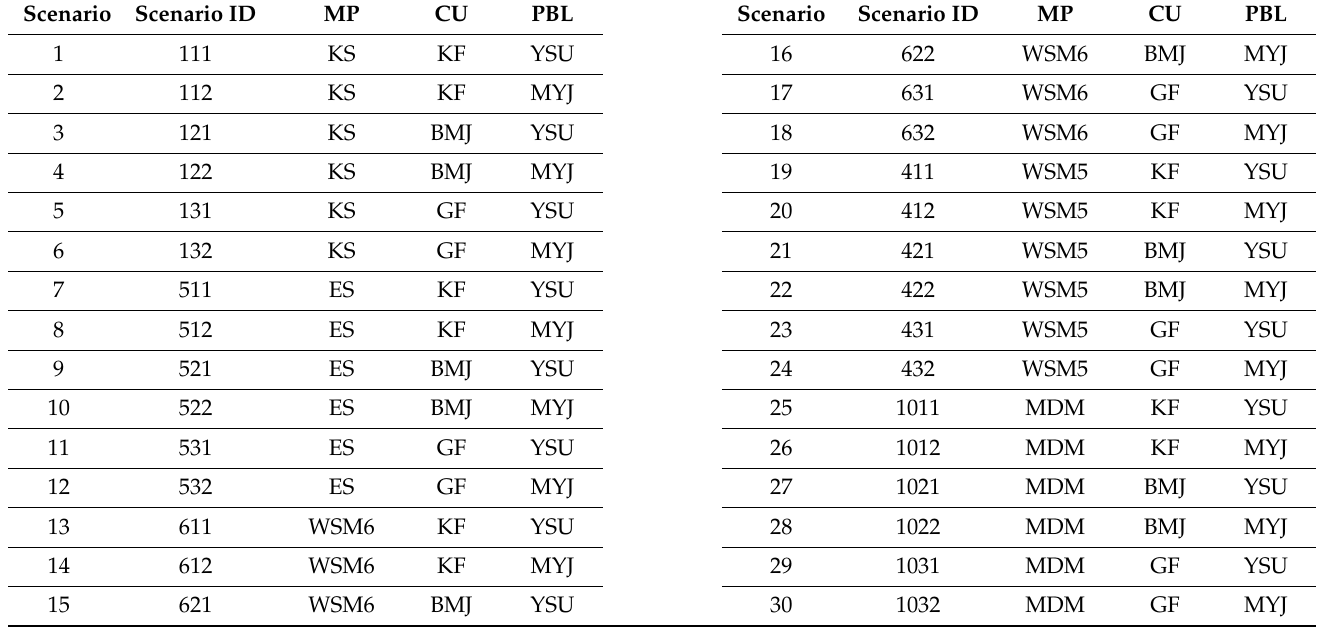
Table 2. Sensitivity analysis